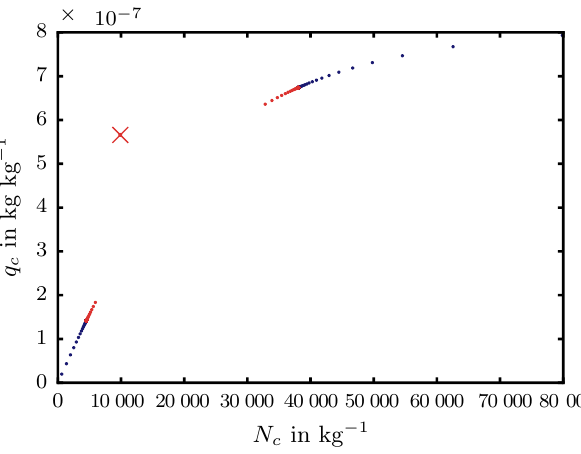
Figure C1. Example of a Poincaré section in the limit cycle regime. Blue dots indicate intersection points of the trajectory with (cid:54) when starting “outside” the cycle; red dots indicate intersection points when starting near the (unstable) equilibrium point x 0 (red cross).